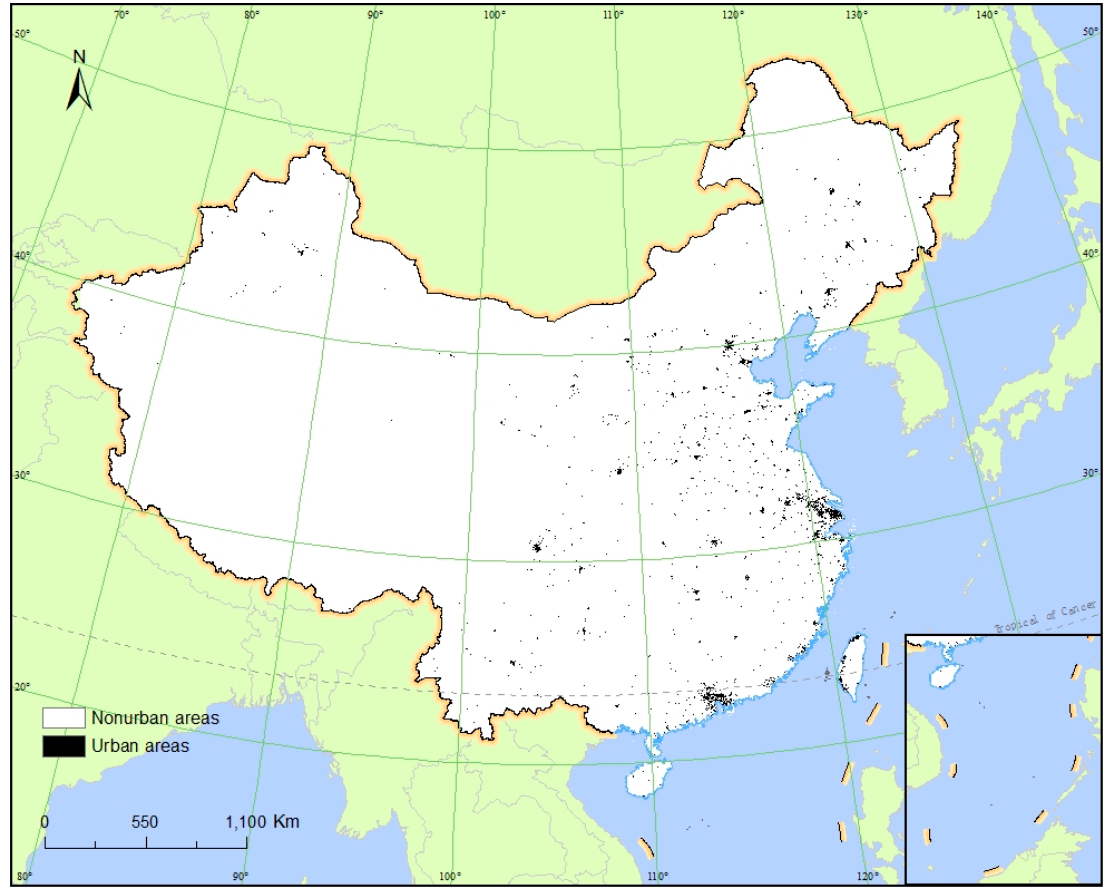
Figure 6. Urban area mapping result of China with VIIRS DNB data from the proposed method (using ED as similarity measure) in Test 3.